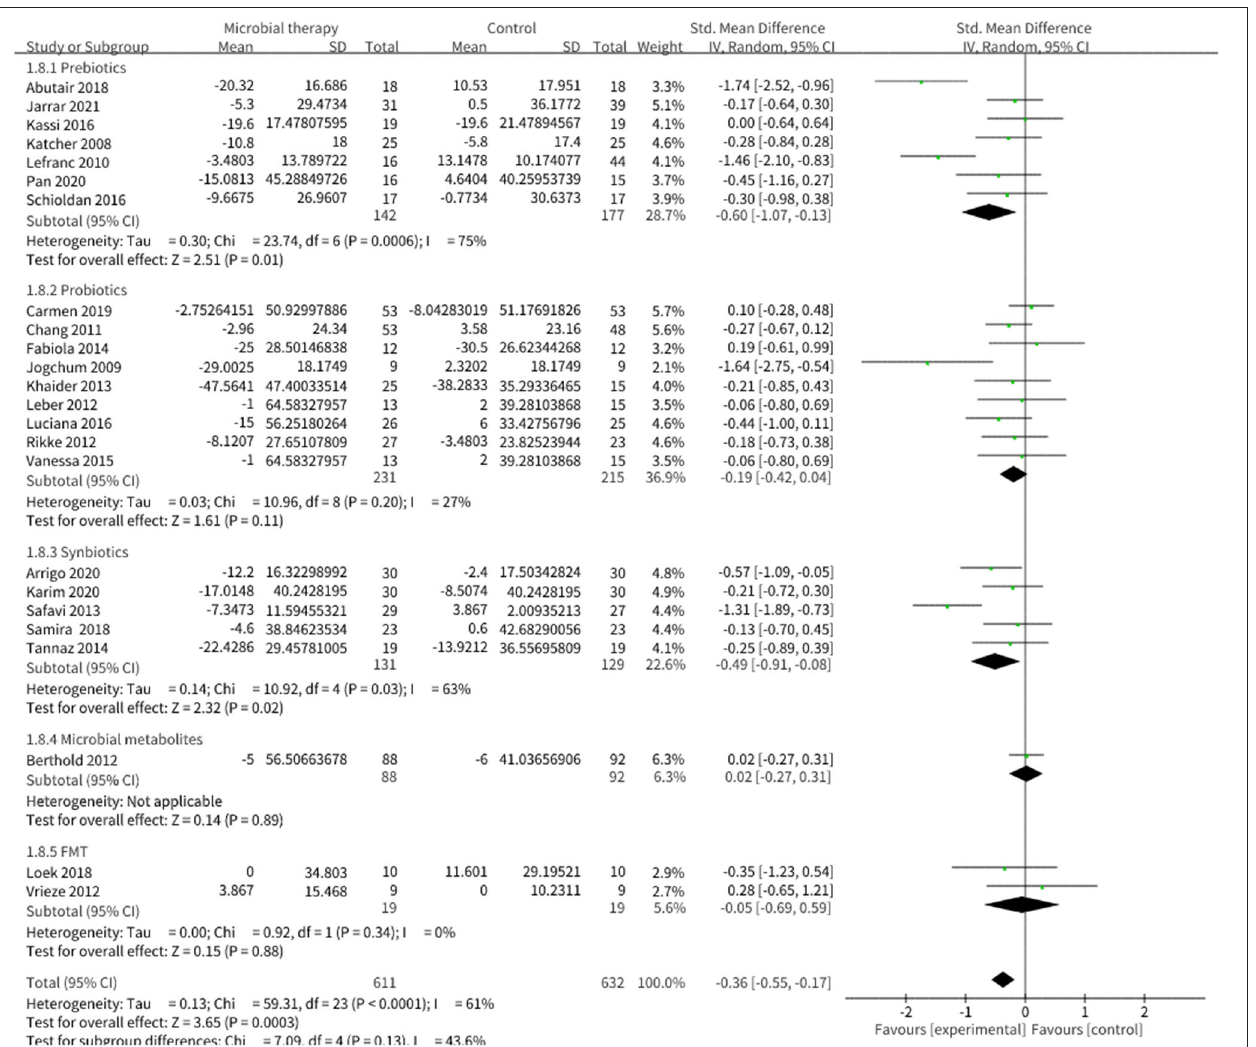
FIGURE 3 | Comparison of SMD of total cholesterol (TC) control between intervention groups and control groups Tau 2 = 0.13, I 2 = 61%, 95% CI − 0.55 to − 0.17, Z = 3.65, p = 0.0003. Significant difference was shown in TC.